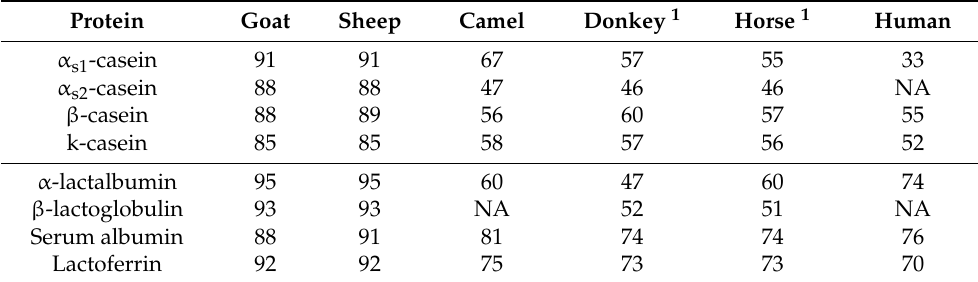
Figure 4. Relationship between present and potential future mammalian milk sources for infant formula manufacture. B. Domesticus (cow), C. hirsus (goat), O. aries (sheep), and C. dromedaries (camel) belong to the order Artiodactyla. Camel belongs to the suborder (Tylopoda), while cow, goat, and sheep belong to the same suborder (Ruminantia) as well as family (Bovidae), with cow belonging to Bovinae subfamily and goat and sheep belonging to Caprinae subfamily. Goat and sheep differ in their genius, where goat belongs to Capra, and sheep belongs to Ovis. Camels belong to Camelidae family, Camelinae subfamily, and genus Camelus . E. asinus (donkey), and E.f. caballus (horse) both belong to the order Perissodactyla as well as the same suborder (Hippomorphia), family (Equidae), subfamily (Equinae), and genus (Equus) and differ only in their species. Graphics created with BioRender.com. Table 2. Amino acid sequence identity percentage (%) between cow and goat, sheep, camel, donkey, horse, and human milk proteins. Table modified from